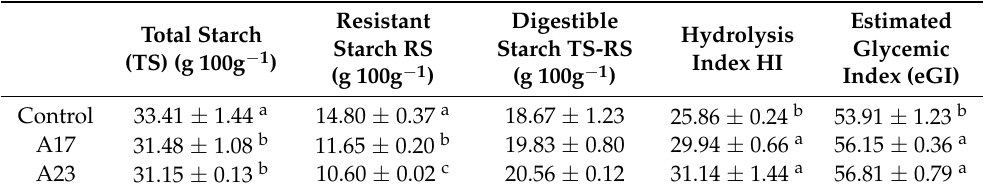
Table 6. Total Starch (TS), Resistant Starch (RS), Digestible Starch (TS-RS), Hydrolysis Index (HI) Estimated Glycemic Index (eGI) values of the GFB C, A17,